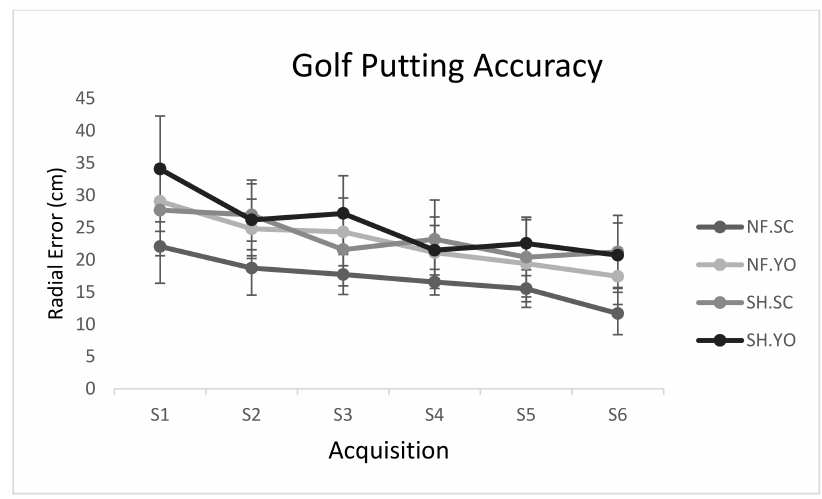
Figure 4. Line chart of golf putting accuracy during acquisition stage. Error bars represent the standard deviation. NF. SC: neurofeedback/self-controlled practice; NF. YO: neurofeedback/yoked practice; SH. SC: sham/self-controlled practice; SH. YO: sham/yoked practice.